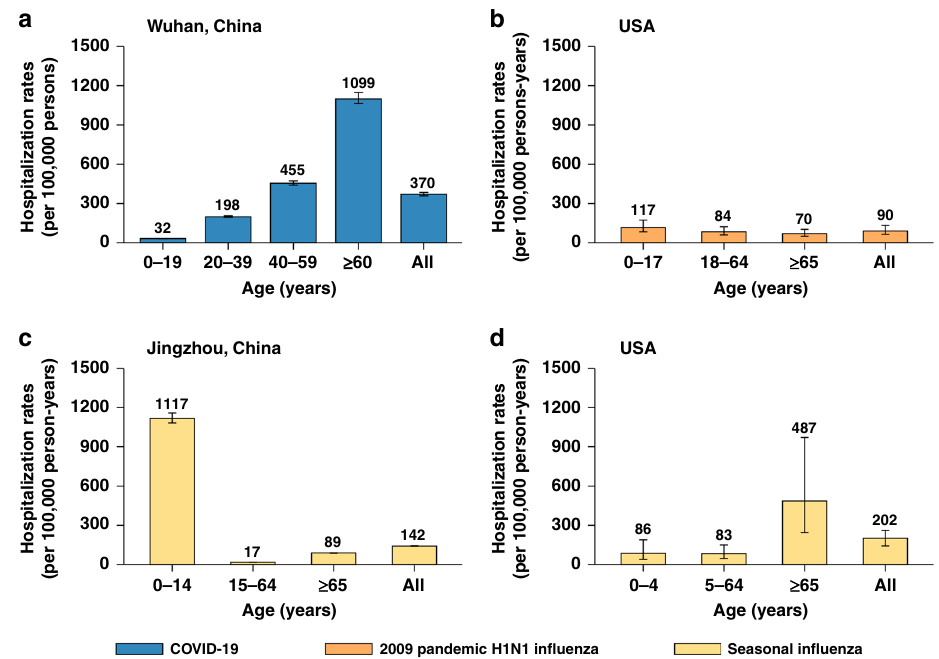
Fig. 3 Hospitalization rates. a Rates of hospitalization associated with COVID-19 in Wuhan, China (mean, 95% CI). The error bars presented 95% CI as estimated using Monte Carlo sampling (10,000 samples from Binomial distributions). b Rates of hospitalization associated with 2009 pandemic H1N1 in fl uenza, USA (median, range) 16 c Rates of hospitalization associated with seasonal in fl uenza related SARI in Jingzhou, Hubei province, China (median, range) 17 . d Rates of hospitalization associated with seasonal in fl uenza, USA (mean, 95% CI) 18,19 .